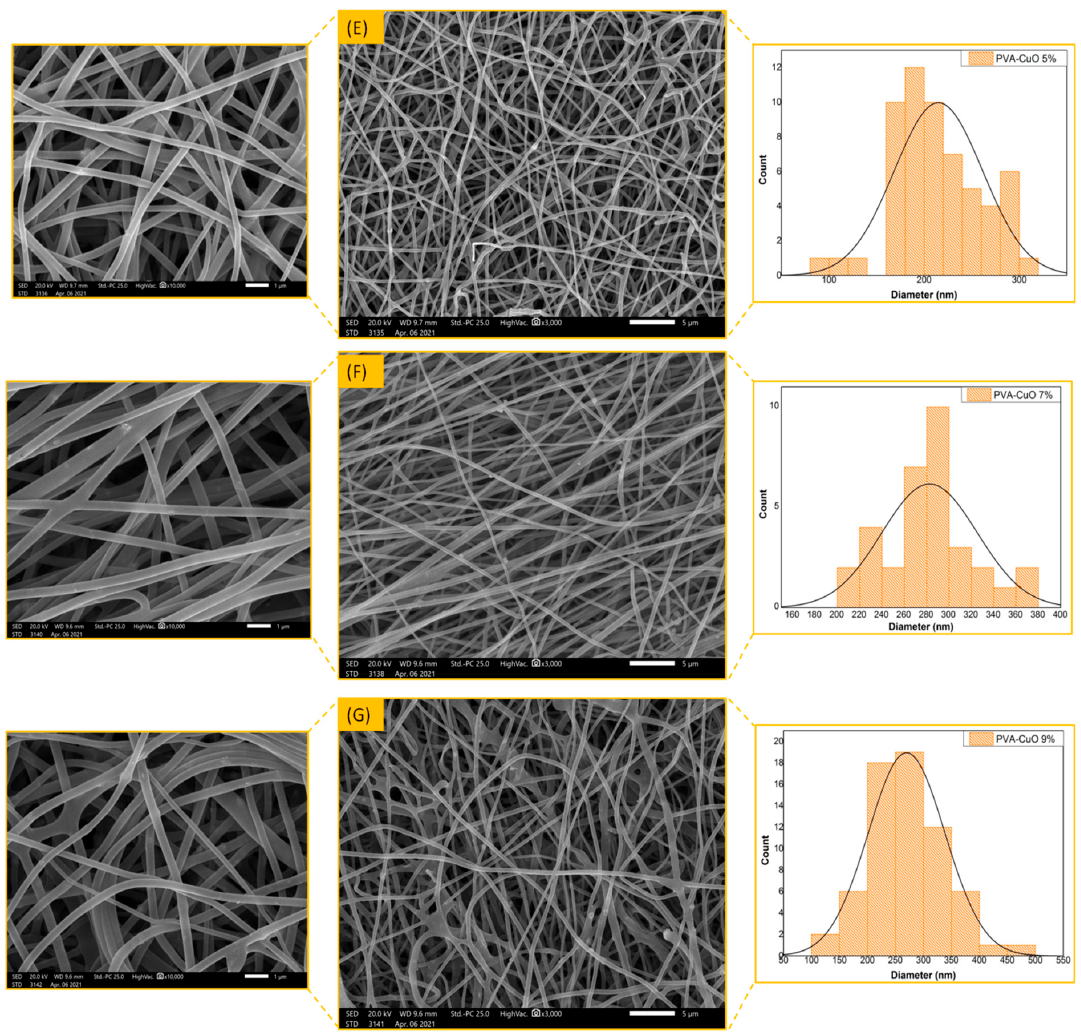
Figure 1. SEM images of PVA ( A ), PVA-ZnO 5% ( B ), PVA-ZnO 7% ( C ), PVA-ZnO 9% ( D ), PVA-CuO 5% ( E ), PVA-CuO 7% ( F ), and PVA-CuO 9% nanofibers ( G ). Table 1. Average Fiber Diameter (nm) of the developed nanofibers.